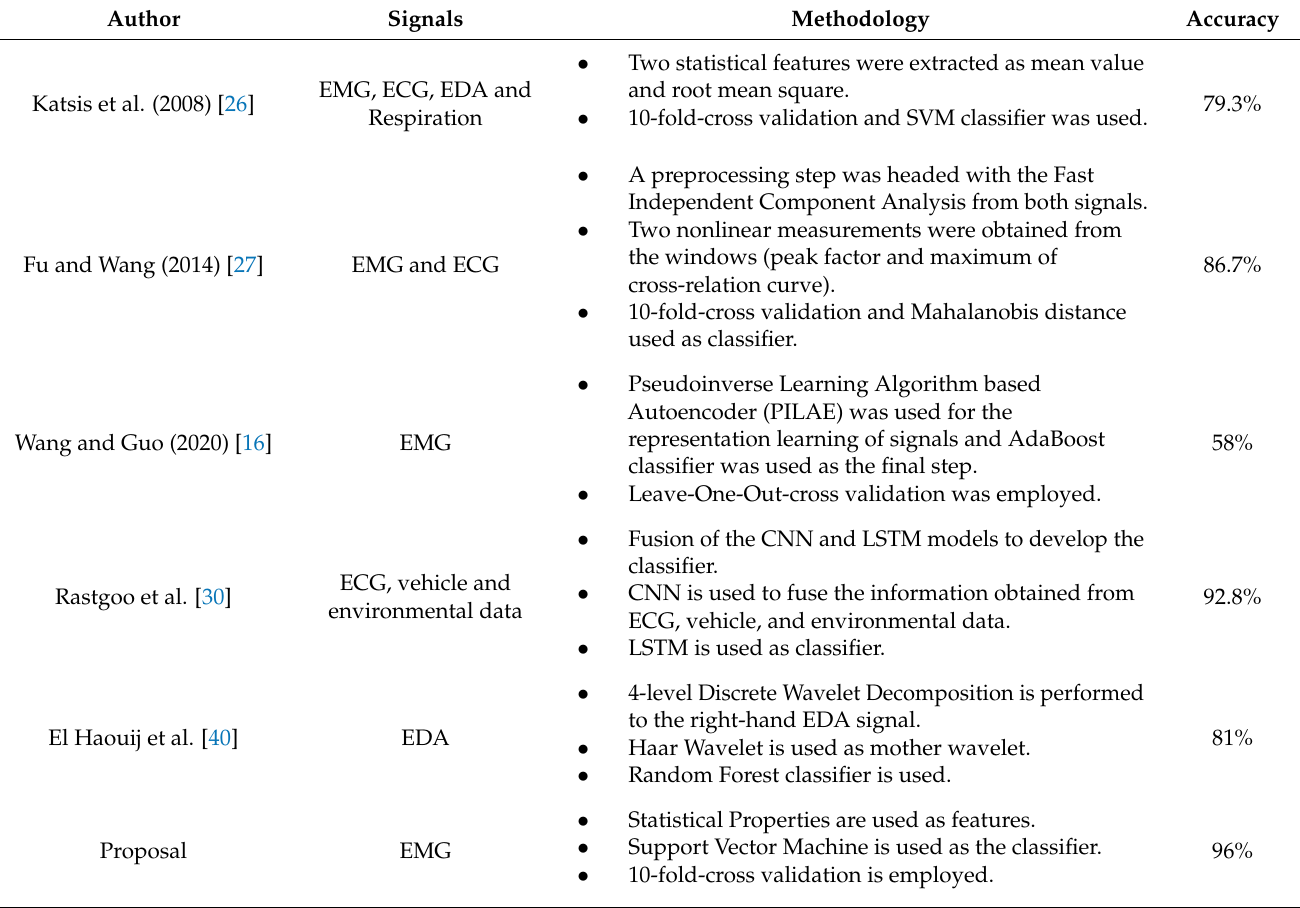
Table 6. Comparison with similar